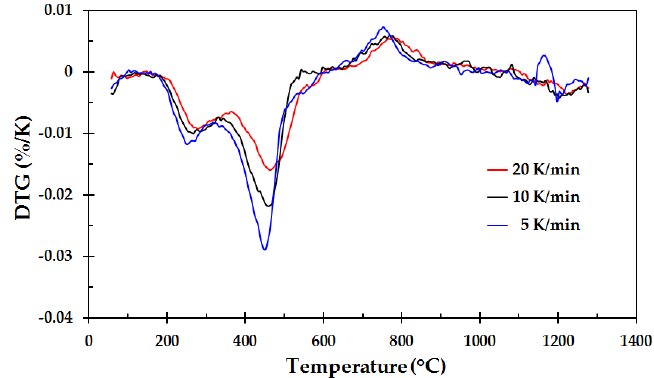
Figure 15. Differential thermogravimetric (DTG) analysis of the results shown in Figure 14.